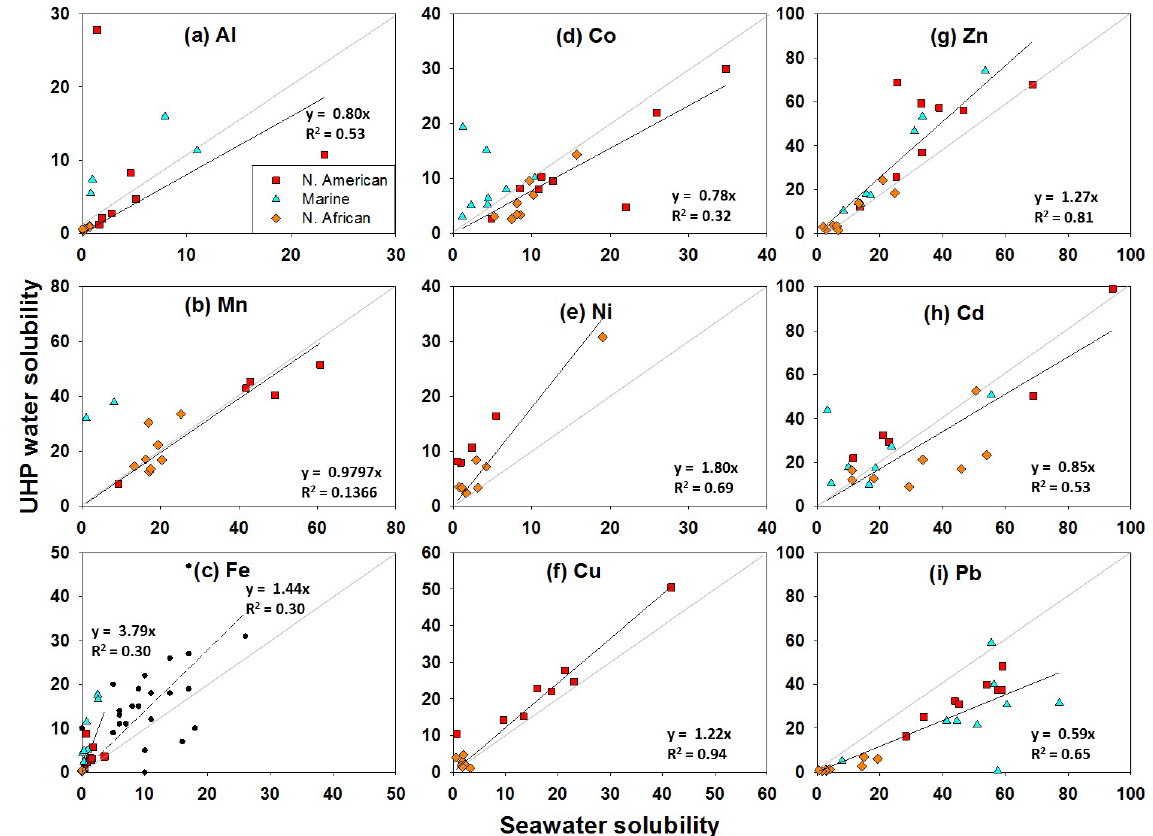
Figure 6. Comparison of TE solubility following instantaneous leaches using UHP water or locally collected, filtered seawater. The solid line is the 1 : 1 line. Where fewer data are observed, concentrations were below detection for one or both of the two leaches. The data for soluble aerosol Fe from within our study region from Buck et al. (2010) are plotted as black circles in panel (c)